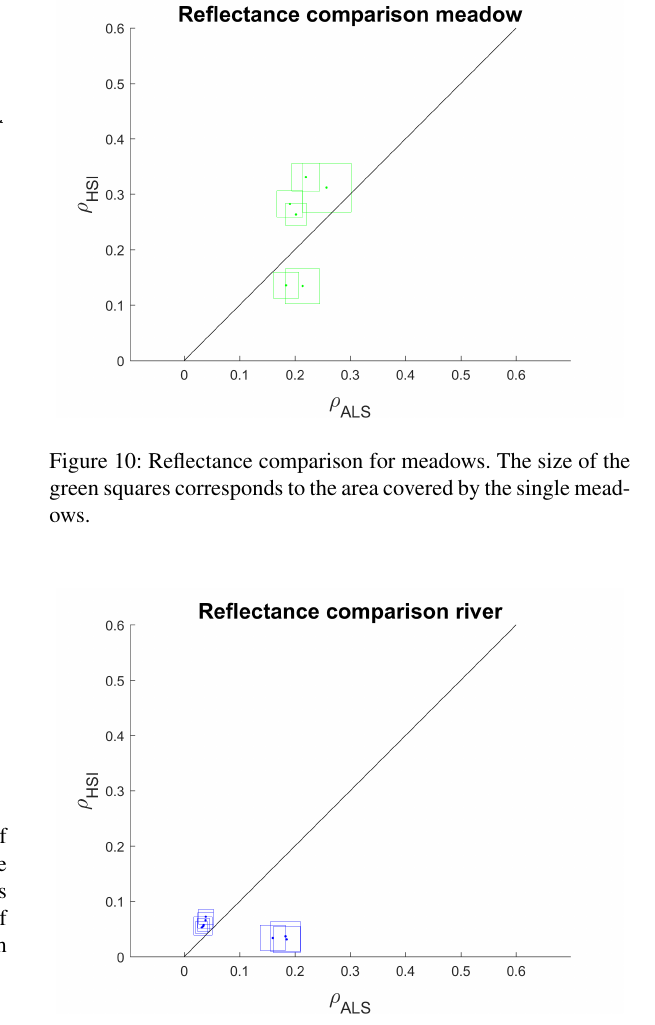
Figure 11: Reflectance comparison for river (Matter Vispa). The size of the blue squares corresponds to the area covered by the single polygons.